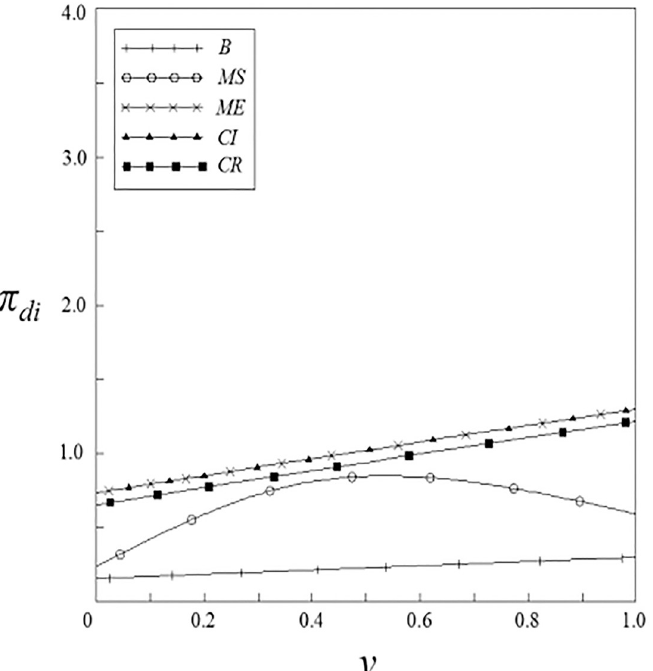
Fig 13. The relationship between π di and ν